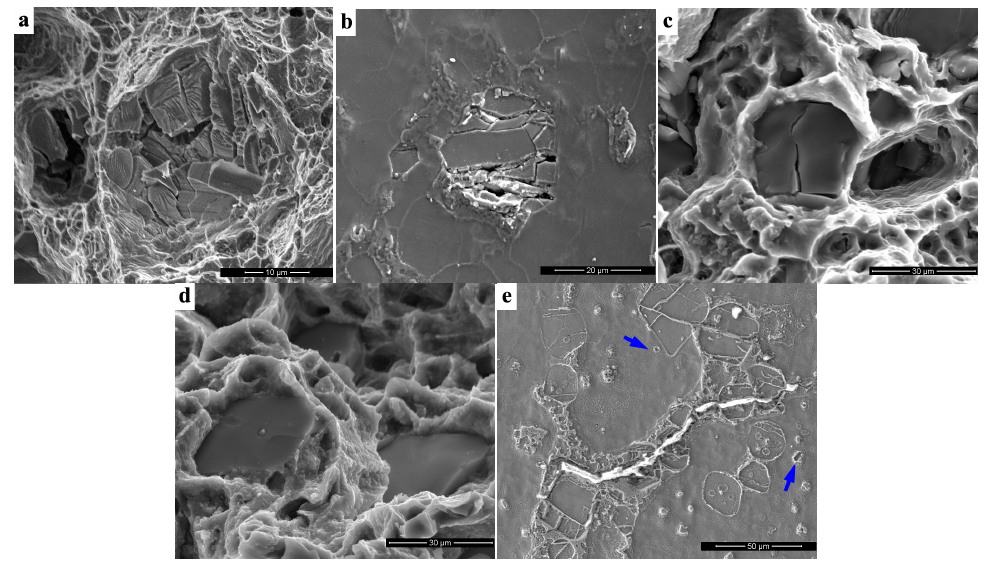
Figure 5. SEM images showing Mg 2 Si particles: ( a , b ) fragmentation on fracture surface and side view of it at 25 °C; ( c , d ) fragmentation and interfacial debonding on the fracture surface at 150 °C; ( e ) showing eutectic Mg 2 Si particle in the side view of the fracture surface at 25 °C. As mentioned above, there are two kinds of Mg 2 Si particles. After tensile testing, the large-sized ones break into pieces and the small-sized ones maintain their original morphology (marked by arrows in Figure 5e). During tensile testing, the interaction between dislocations and fine particles also contributes in strengthening the matrix through the Orowan looping mechanism [29]. As the testing temperature rises, the dislocation motion is promoted from the accelerated atom diffusion ability. In this case, the Orowan looping mechanism operates increasingly as the testing temperature